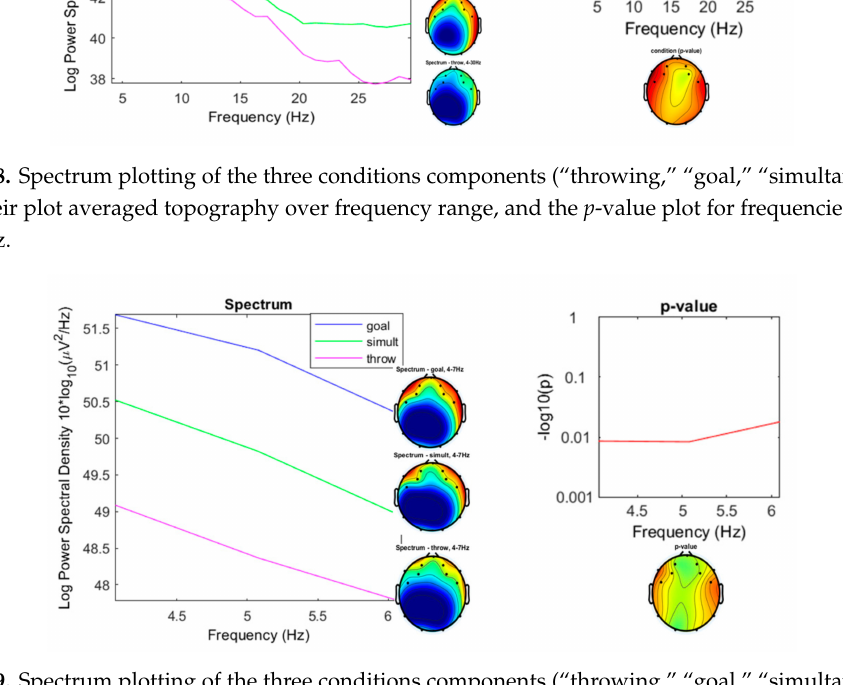
Figure 9. Spectrum plotting of the three conditions components (“throwing,” “goal,” “simultaneous”), with their plot averaged topography over frequency range, and the p -value plot for frequencies from 4 to 7 Hz (Theta).